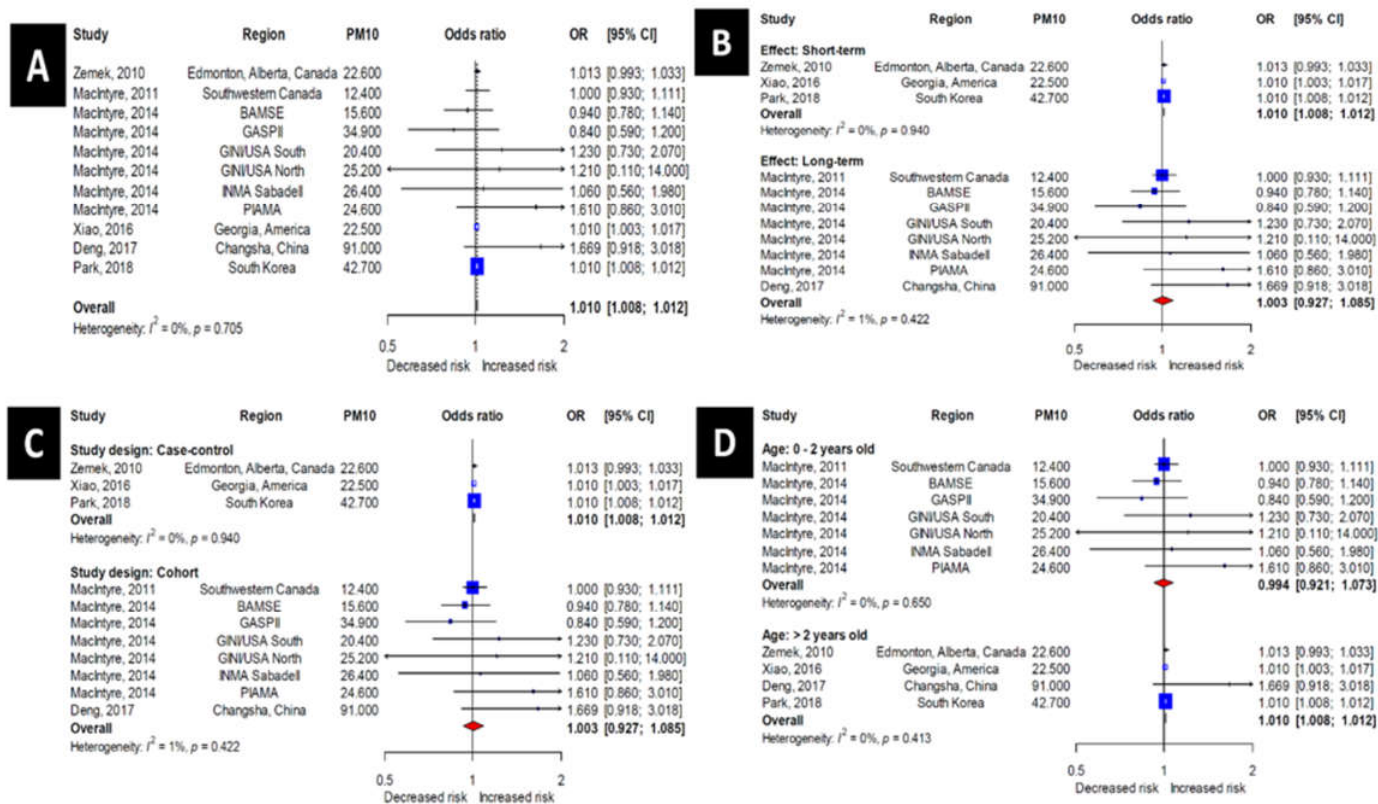
Figure 3. Forest plots for the PM 10 group. (A)— All subjects. (B) —Short- and long-term effect models. (C) —Case–control and cohort studies. (D) —Younger and older children.